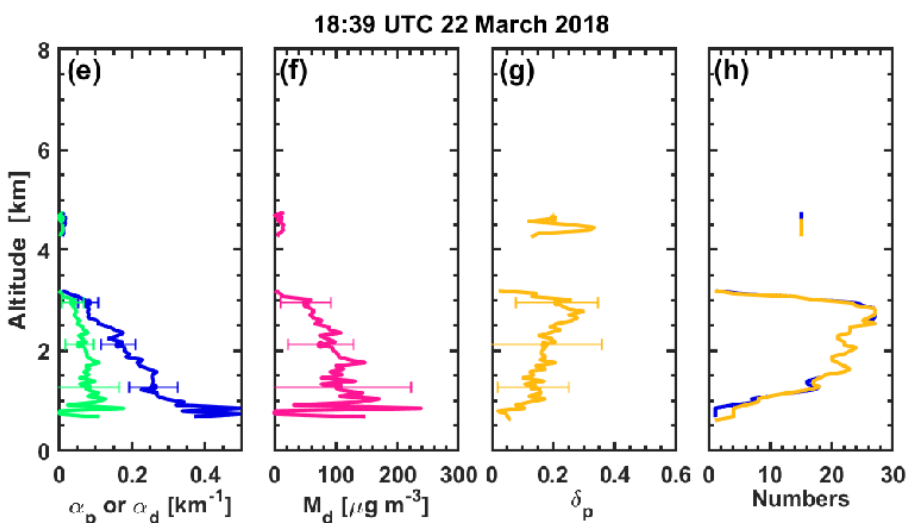
Figure 11. Profiles of dust and total particle (dust + non-dust) extinction coefficients ( a ), dust mass concentrations ( b ), and particle depolarization ratios ( c ) observed by CALIOP over the Jianghan Plain (29.0° – 32.0° N, 113.0° – 113.7° E) from 05:51:46 to 05:52:35 UTC on 21 March. ( d ) shows the number of data points in each vertical bin for calculating the averaging 𝛼 p , 𝛼 d , 𝑀 d , and 𝛿 p . ( e – h ) are the same but over another part of the Jianghan Plain (30.0° – 32.0° N, 111.0° – 111.5° E) from 18:39:44 to 18:40:15 UTC on 22 March. The error bars represent the standard deviations. The aerosol profile on 24 March has little valid data so it is not shown.